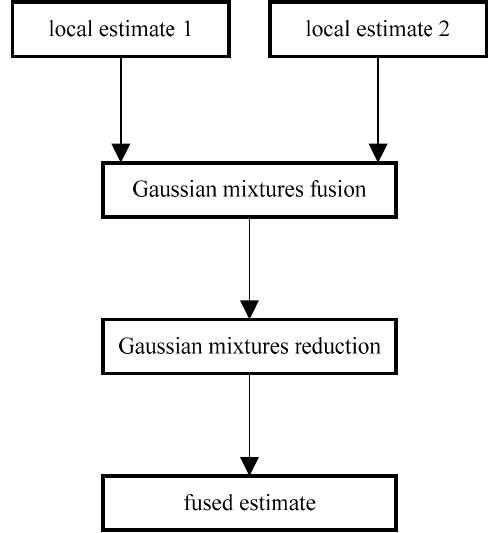
Figure 3. Flow chart of the fusion methodology.